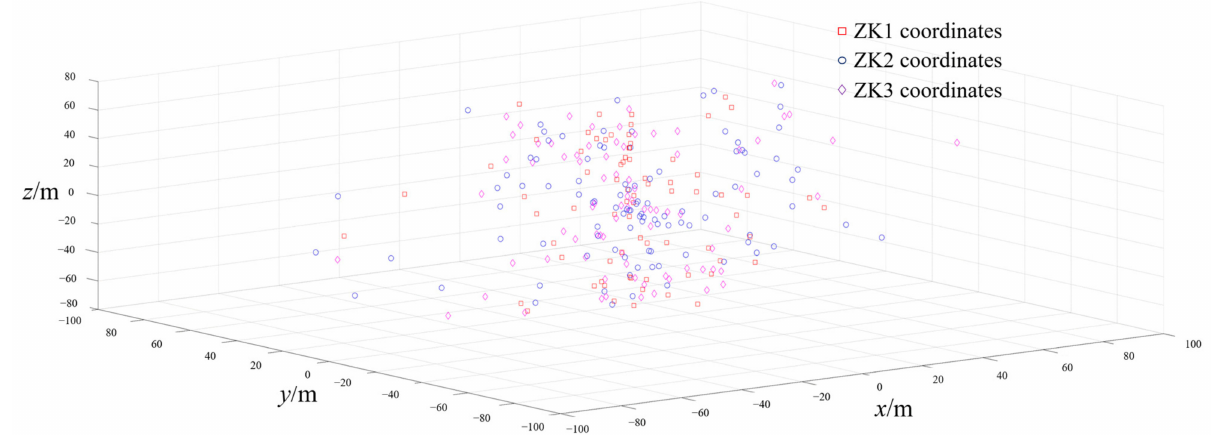
Figure 15. Coordinates diagram of the structural surface in the three